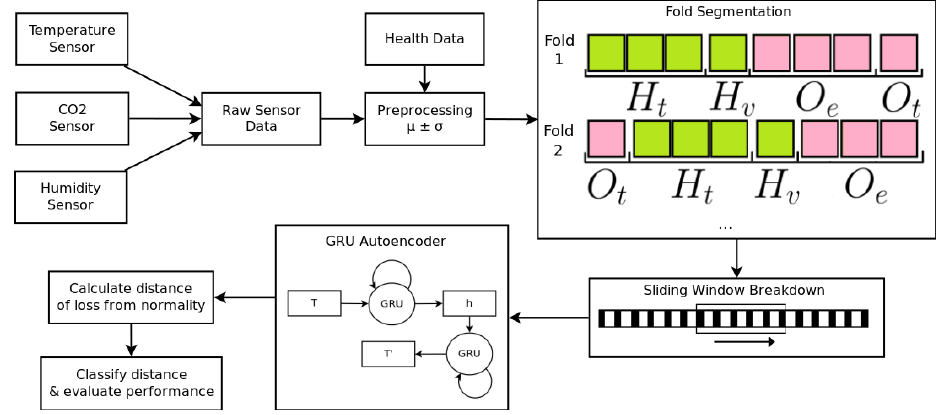
Figure 4. An overview of the entire processing workflow, from the raw sensor data to anomaly detection. Temperature, CO 2 , and humidity sensors were preprocessed and merged with daily health data. This was then broken down into four folds— H t and H v (used for the GRU-AE), and O e and O t (used for the anomaly detection). Each of these folds were broken down using a sliding window sized at 30 min. Each window of 30 min was processed by the GRU-AE, and a reconstruction error was produced. The distance between this reconstruction error and normality was used to detect whether the window is anomalous or not, using a threshold-based anomaly detector optimised using particle swarm